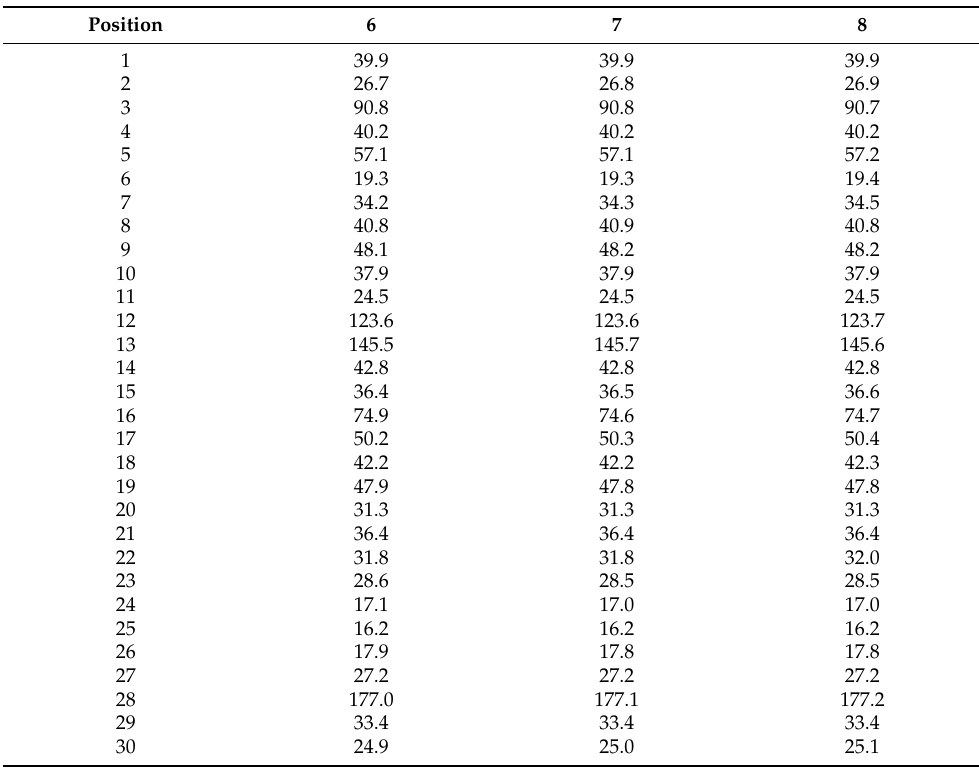
Table 4. 13 C NMR data for the aglycone moieties of 6–8 (200 MHz, CD 3 OD).